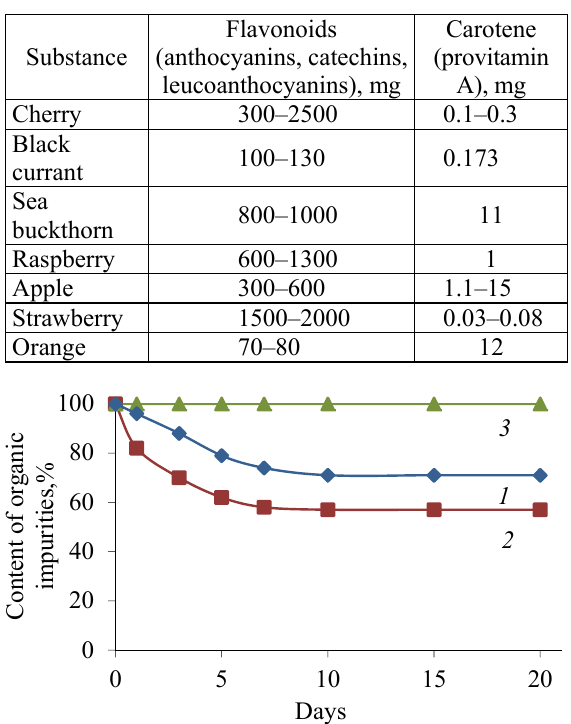
Fig. 8. Change in the content of trichlorethylene ( 1 ), dichloroethane ( 2 ) and chloroform ( 3 ) in water in the presence of vanillin over